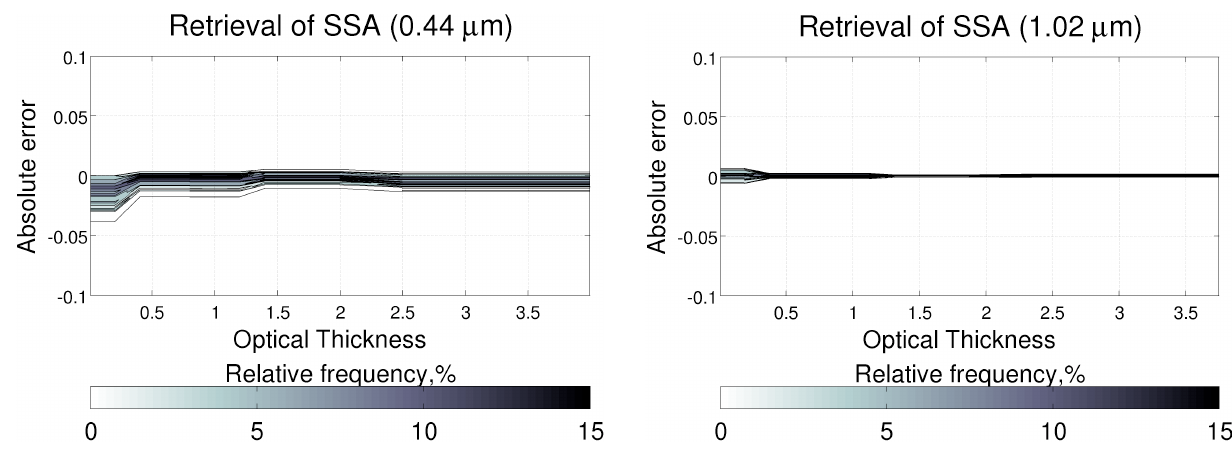
3 Fig. 19. Statistics of the retrieval errors of desert dust single scattering albedo over Banizoumbou in the series of the numerical tests for 100 different realizations of random noise added (multi-pixel retrieval): (left panel) 0.44µm; (right panel)